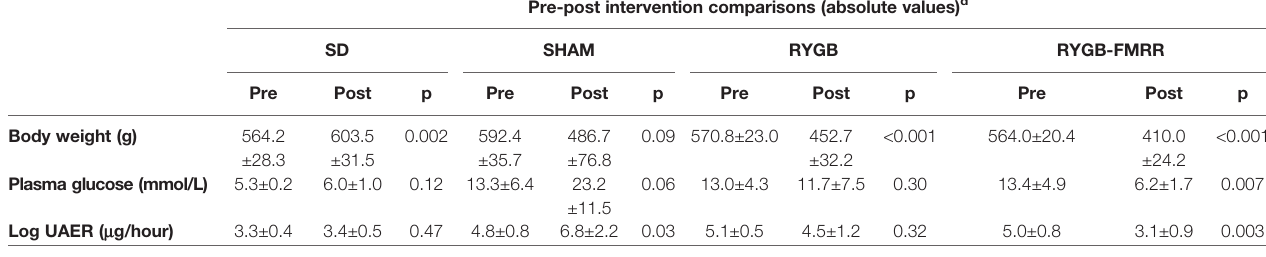
TABLE 2 | Changes in body weight, plasma glucose, urinary albumin excretion, and serum lipids by experimental group. a,b,c